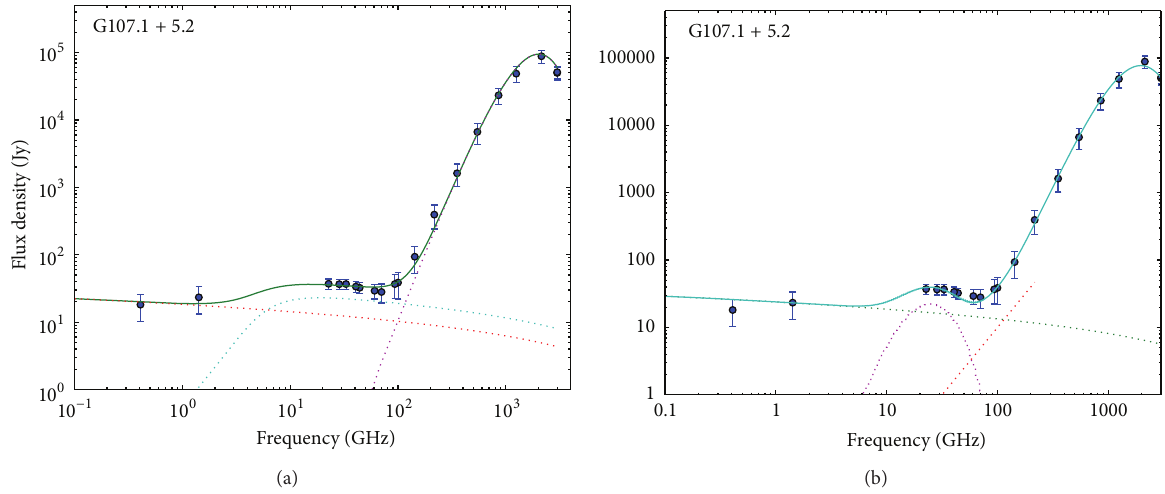
Figure 8: Spectrum for G107.1+5.2 at ≈ 1 ∘ scales, from Planck , WMAP, and ancillary datasets (data points as in [3]). (a) Fitted with a two- component free-free model. The two free-free components are shown as red and blue dotted lines and the contribution from the thermal dust greybody as a purple dotted line. The combined model is shown as a solid green line. Model parameters are listed in Table 3. (b) Fitted with a free-free plus spinning dust model, the free-free component is shown as a green dotted line and the spinning dust component as a purple dotted line. The Rayleigh-Jeans tail of a CMB component is shown as a red dotted line, with the thermal dust greybody model excluded for clarity. The combined model is shown as a blue solid